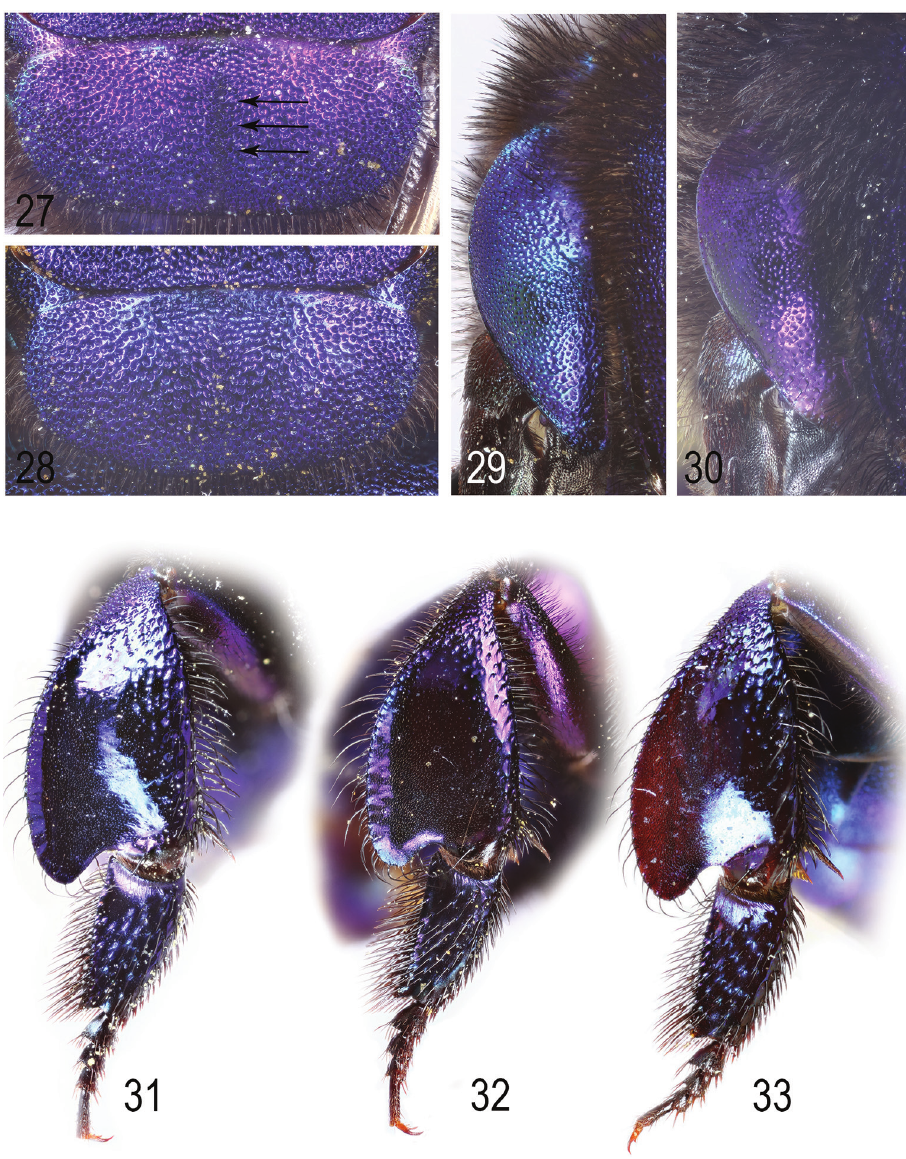
Figures 27–33. Dorsal views of female mesoscutellum ( 27, 28 ) and tegula ( 29, 30 ), and outer view of hind leg ( 31–33 ). 27 E. barthelli (paratype. Mexico: Morelos, Tepoztlán, UNAM 01827) 28, 33 E. oliveri (paratype. Mexico: Guerrero, EMEC 1069136) 29, 31 E. coerulescens (Mexico: San Luis Potosí, ECO-TAP-E-104700; Querétaro, ECO-TAP-E-104753) 30, 32 E. micheneri (paratype. Mexico: Jalisco, Mascota, KUNHM-ENT 1121708). Arrows in Fig. 27 indicate the distinct medial longitudinal groove with row of dense